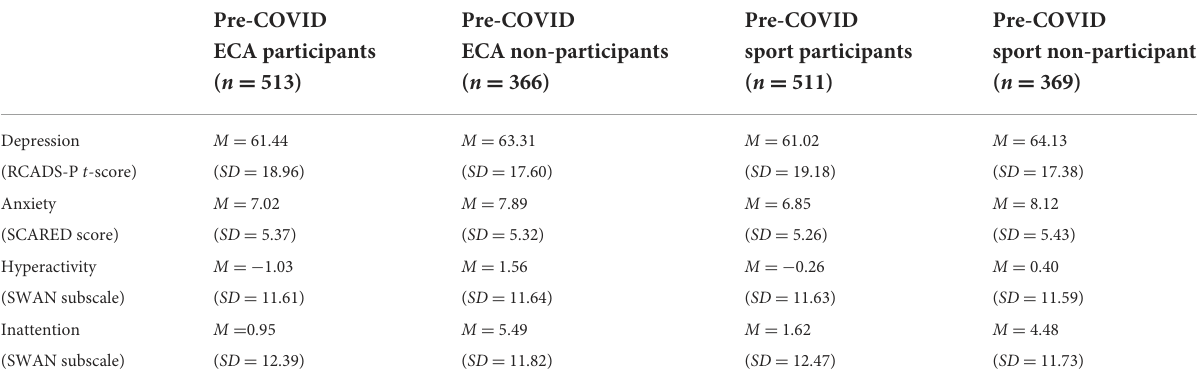
TABLE 2 Mean current mental health scores by domain and measure in pre-COVID and during-COVID extracurricular activity and sport participants and non-participants. Pre-COVID participant and non-participant mental health